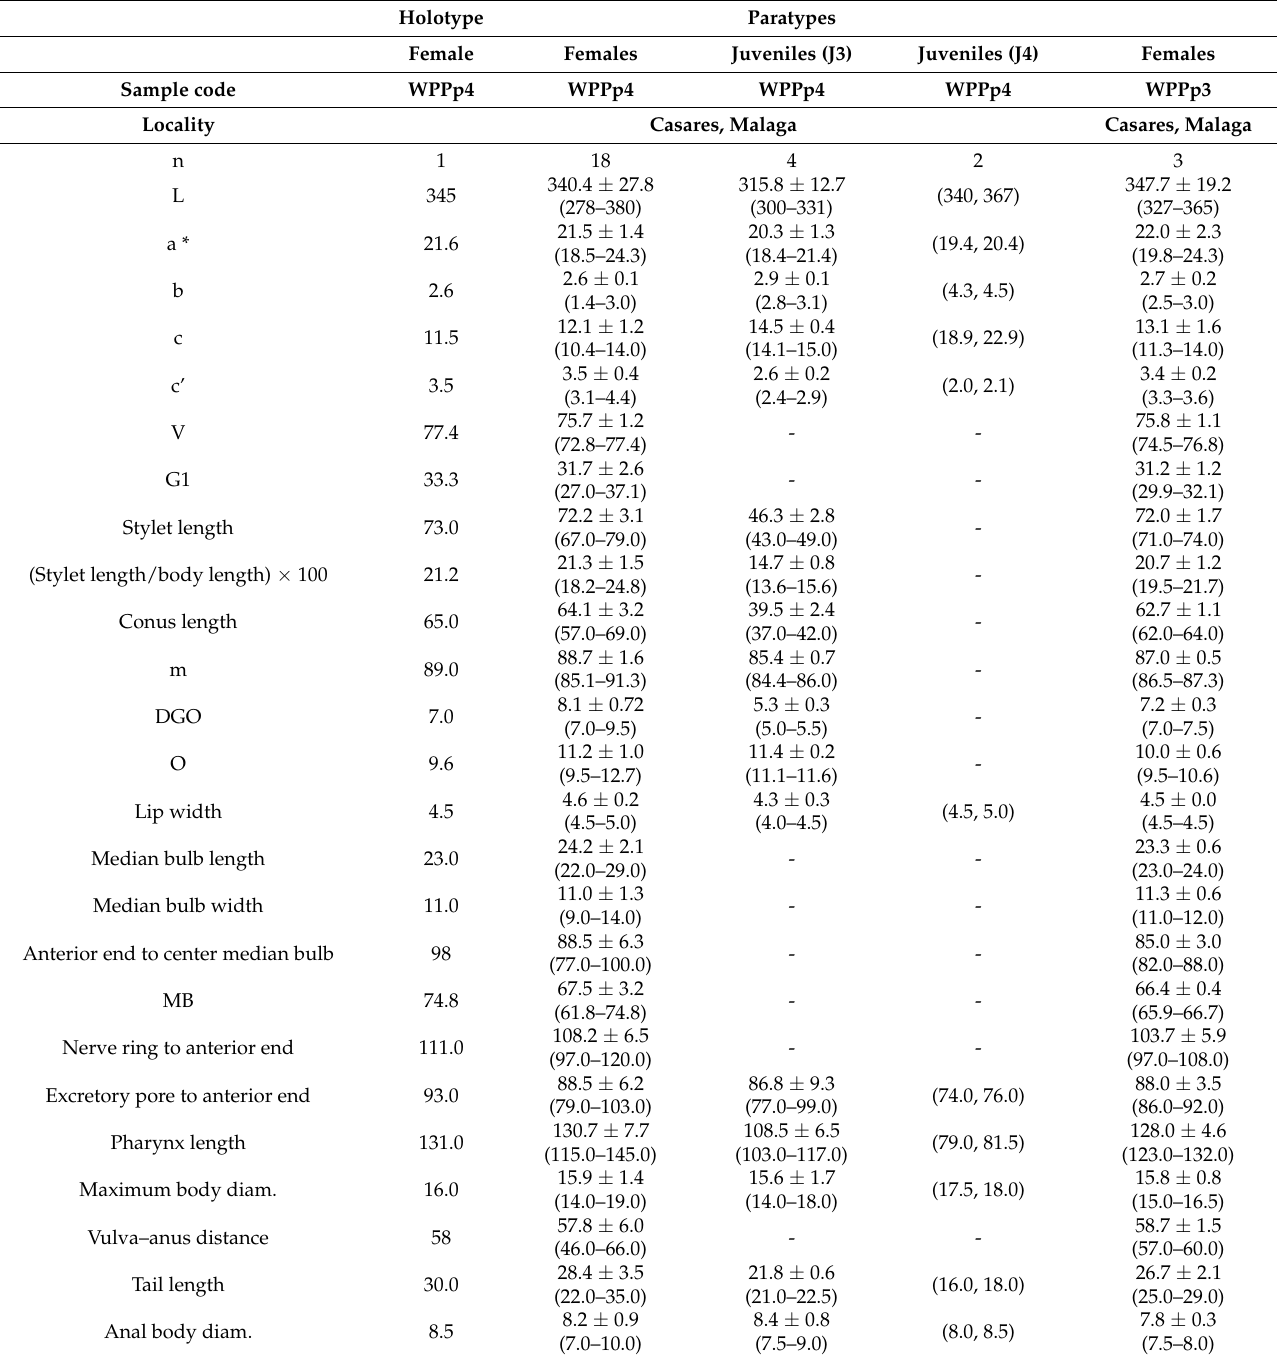
Table 2. Morphometrics of Paratylenchus paraaonli sp. nov. paratype females, third- and fourth-stage juveniles, and an additional population. All measurements are in µ m and in the form: mean ± s.d.